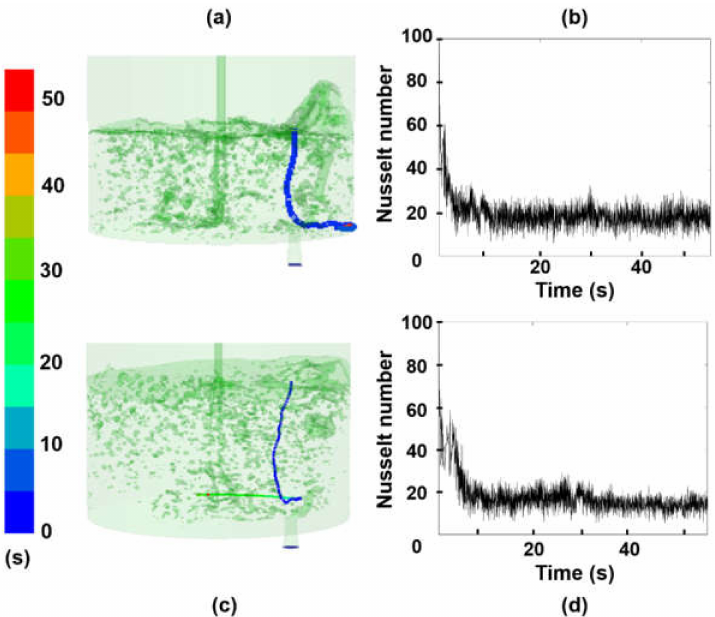
Figure 4. Particle trajectories, residence times, and Nusselt numbers at bath level of 50 tons. ( a ) A 3D view of the multiphase flow at a level of 30 tons, addition point is N2. ( b ) Variations of the Nusselt number with time after the particle falls in point N2 at a bath level of 50 tons. ( c ) A 3D view of the multiphase flow at a level of 50 tons, addition point is N2. ( d ) Variations of the Nusselt number with time after the particle falls in point N2 at a bath level of 50 tons. Steel superheat is 15